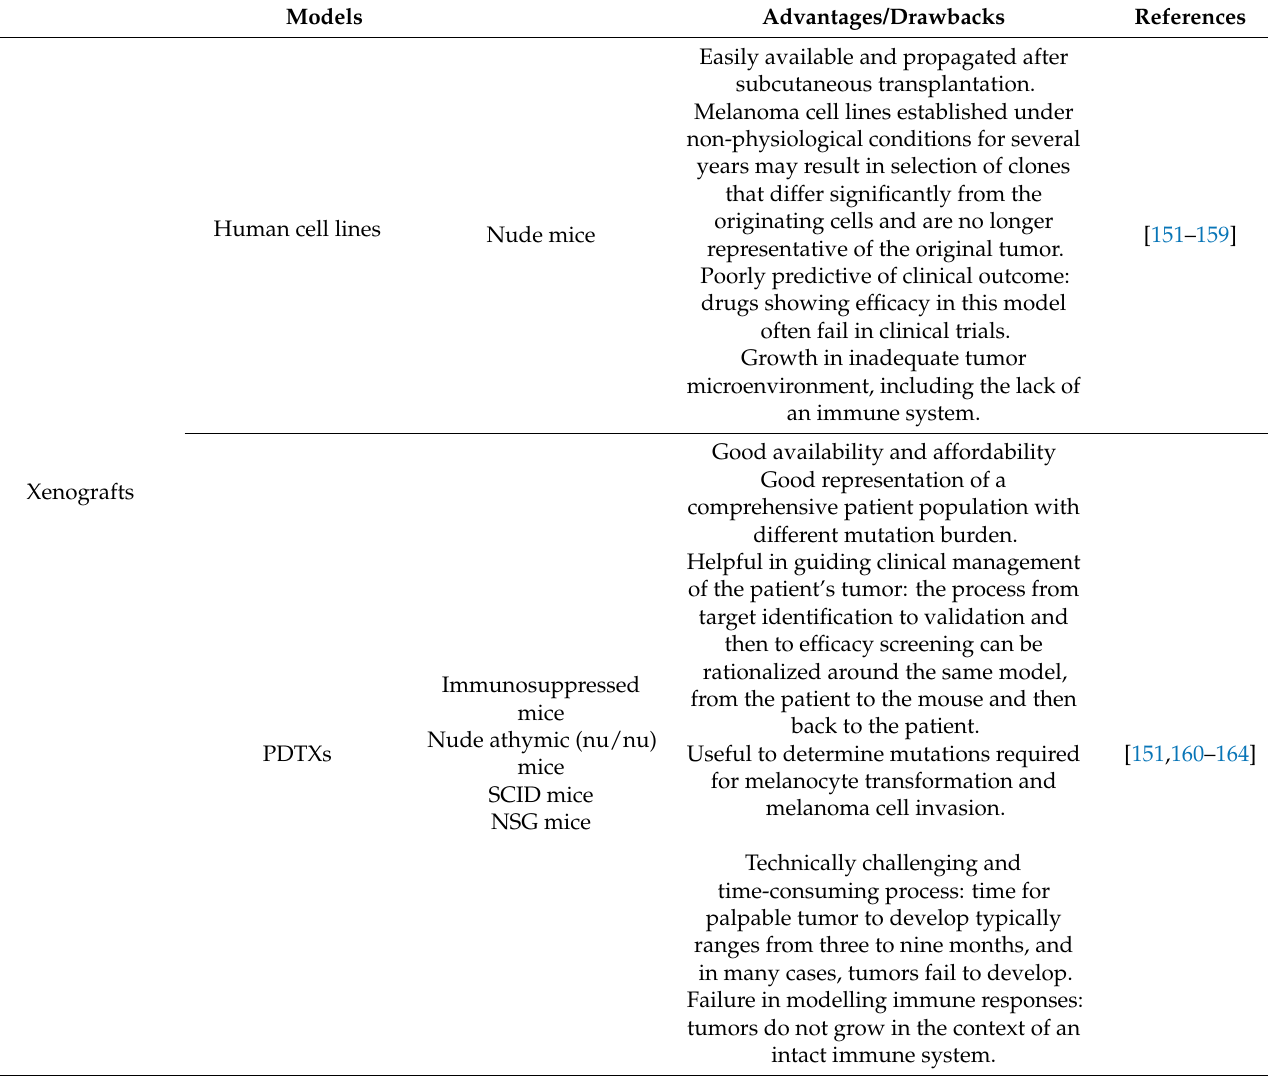
Table 2. Animal models in melanoma